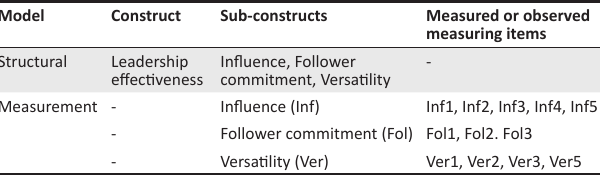
TABLE 9: Definition of structural and measurement model for leadership effectiveness and its constructs.